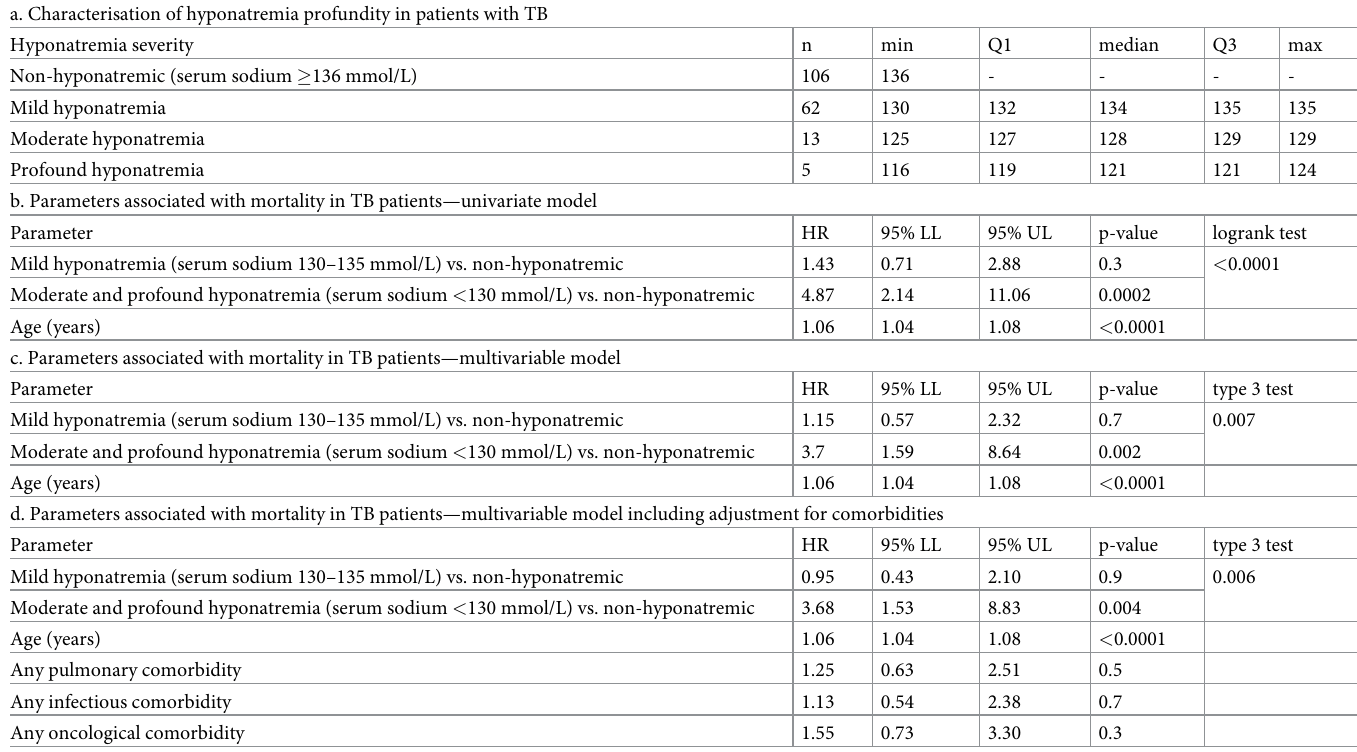
Table 3. Increased mortality in patients with TB with moderate to profound hyponatremia. Patients with TB and moderate to profound hyponatremia episodes had a significantly higher all-cause mortality rate. After correcting for hyponatremia-related comorbidities (Table 1), the effect remains significant. A Cox regression model was calculated with hyponatremia groups and age as independent variables and reported as hazard ratio (HR) with a 95% confidence interval (95%LL, 95% UL) and p-value (H0: HR = 1). TB, tuberculosis. LL, lower limit. UL, upper limit. Q1, first quartile. Q3, third quartile. a. Characterisation of hyponatremia profundity in patients with TB Hyponatremia severity